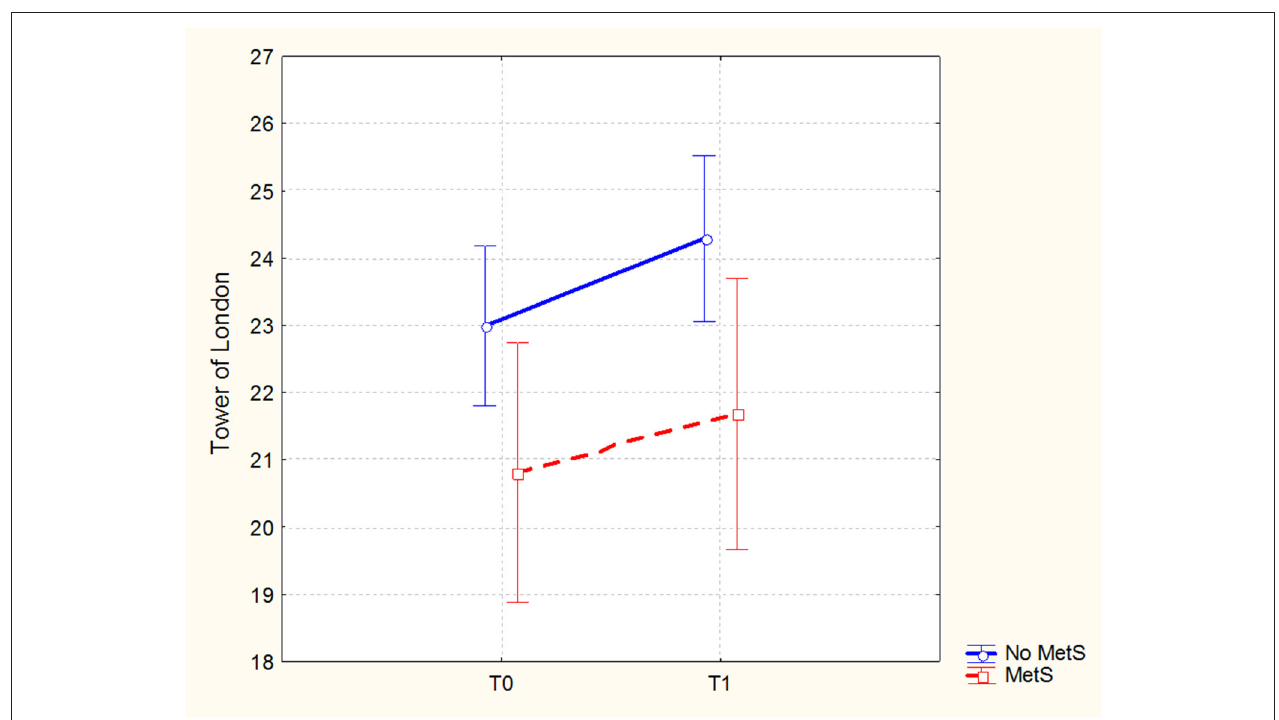
FIGURE 1 | Executive functions (Brief Assessment of Cognition in Schizophrenia-BACS, Tower of London adjusted mean scores and 0.95 confidence intervals) from pre- to post-cognitive remediation therapy in patients stratified by metabolic syndrome.